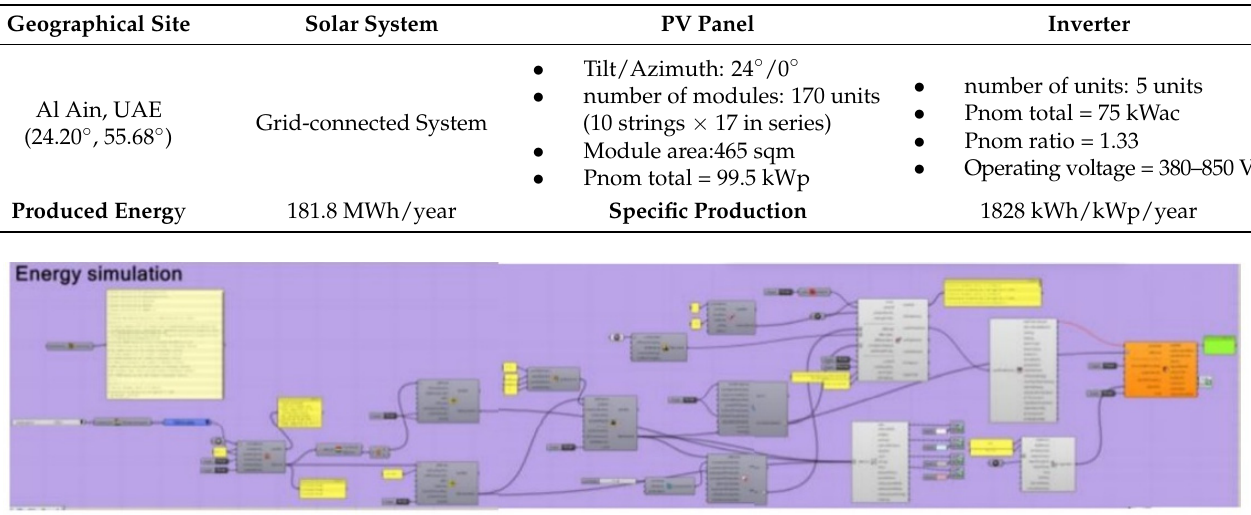
Figure 26. Python language script for Grasshopper, energy simulation (illustrative purpose only).